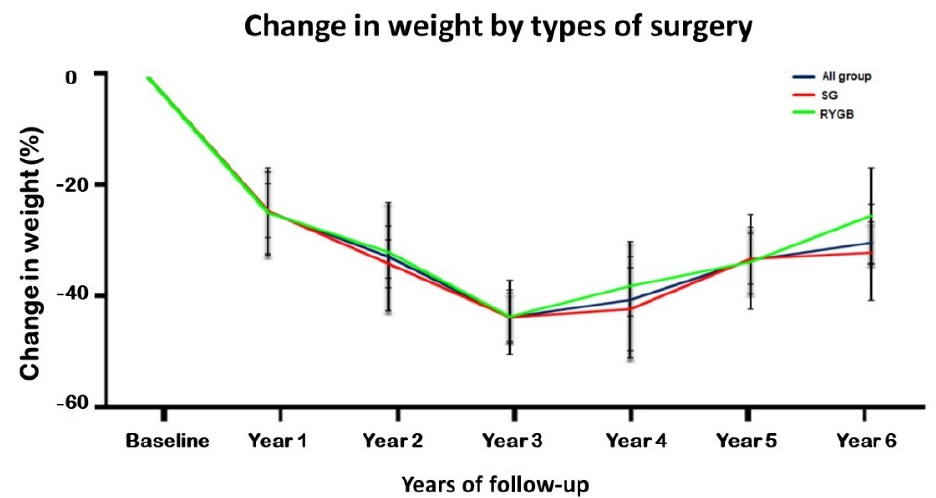
Figure 1. Graphical representations of changes in weight (%), with the error bars representing the ±2 SD during the 6-year follow-up period for all patients who underwent bariatric surgery (blue line), for those who underwent SG (red line), and those who underwent RYGB (green line).